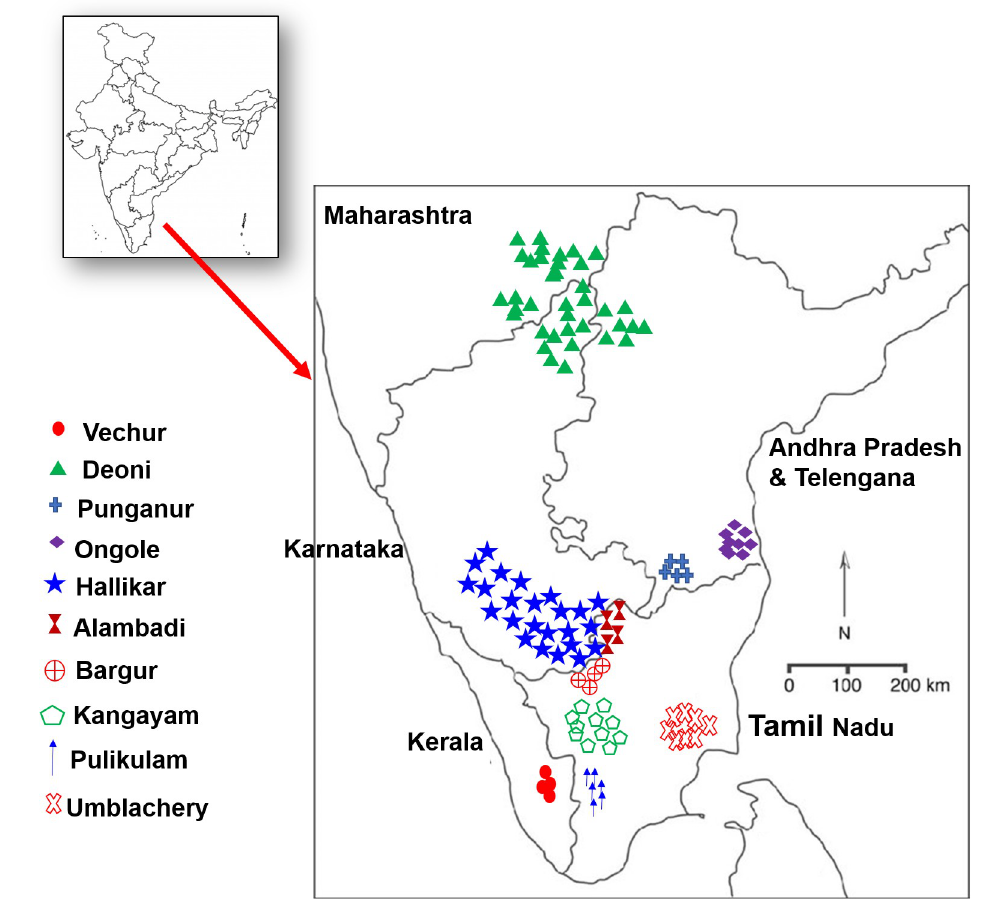
Fig 1. Geographical distribution of the investigated South Indian zebu cattle